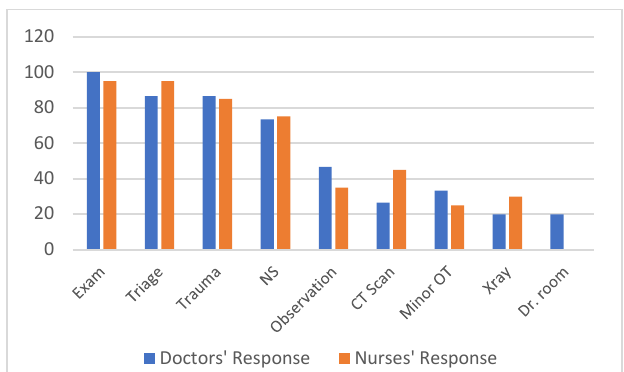
Fig. 9. Order of the most used spaces of the emergency department (Users’